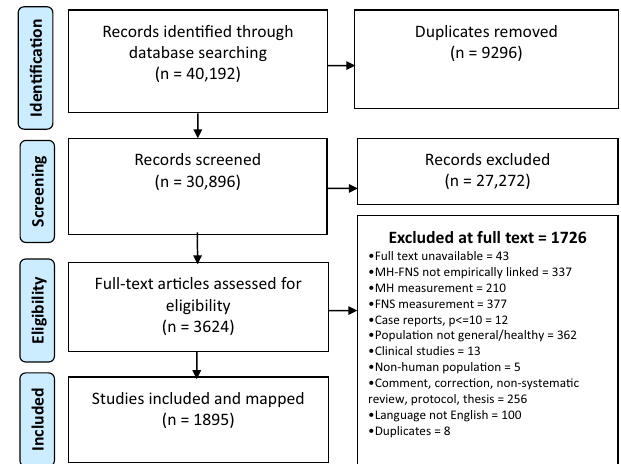
Fig.1| PRISMAFlowchart. Numberof identi fi edstudiesfromsearchateachstage of